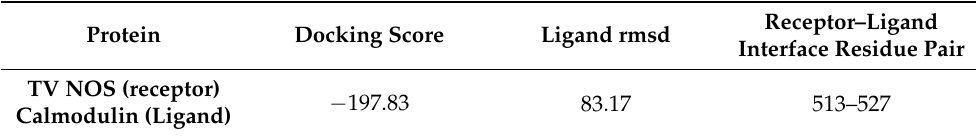
Table 2. Prediction of protein–protein interactions by HDOCK of TV